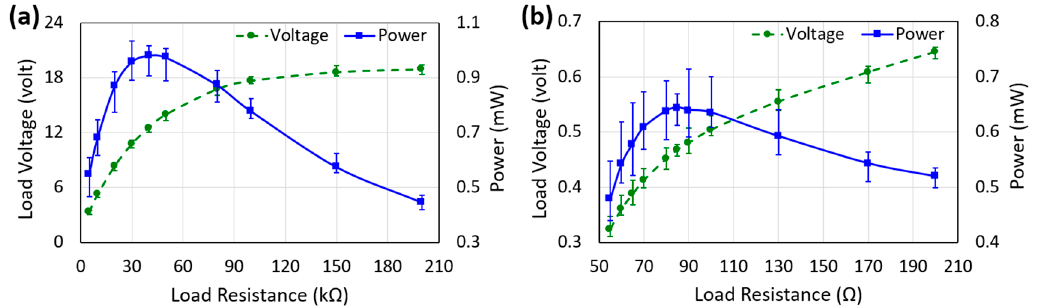
Figure 6. Measured voltage and power vs. load resistances connected to the piezoelectric ( a ) and electromagnetic ( b ) transducers while excited by human-limb motion.